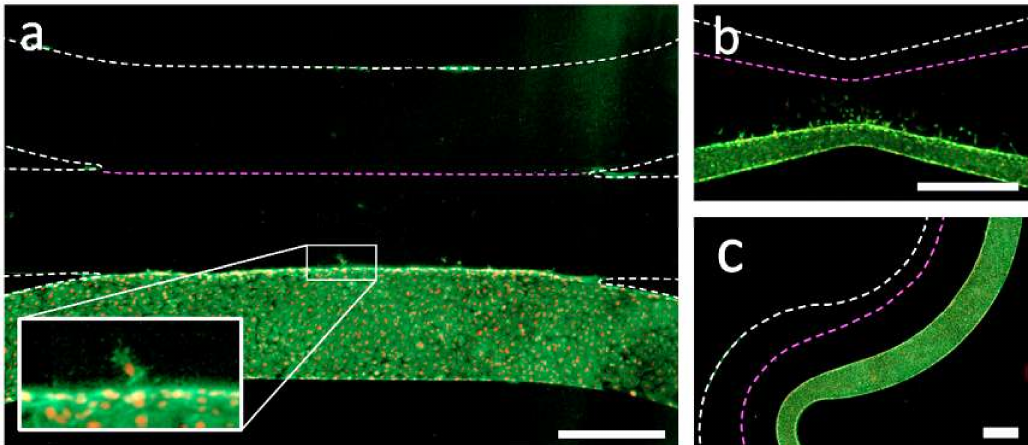
Figure 4. Human endothelial cells are confined by the patterned gel geometries and migrate into the gels. ( a ) Simple 3-channel geometry with patterned hydrogel in the center after 5 days of culturing. Endothelial cells show normal F-actin (green) and nuclear (red) staining. Few cells have spontaneously migrated into the gel (inset). ( b ) Cells grown in a device with an hourglass geometry. ( c ) Cells grown in a meandering channel. The boundary between the gel and the non-cultured fluidic access channel is indicated by the dotted pink lines, and the dotted white lines indicate the walls of the microfluidic channel. Scale bars are 500